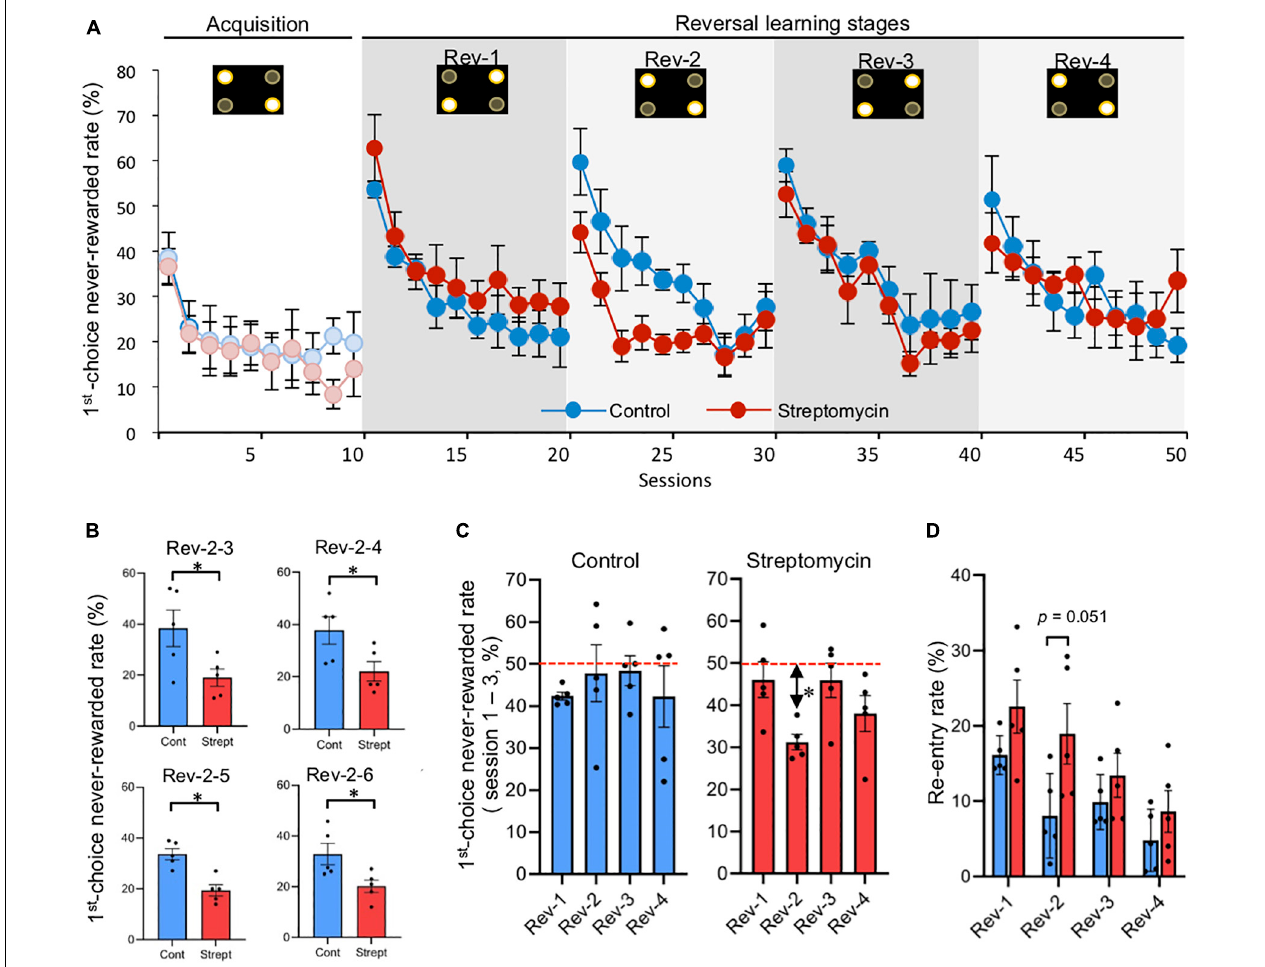
FIGURE 3 | Differences of first-choice never-rewarded rate between control mice and streptomycin-treated mice during serial reversal learning stage (sessions 11–50). (A) Change of first-choice never-rewarded rate (described in Figure 1E ) of both control mice and streptomycin-treated mice are shown ( n = 5/group). Error bars represent SEM. Active and inactive spots (described in Figure 1C ) are shown in the upper part of graph in each stage. (B) The difference between groups of the first choice never-rewarded rates in each session in the reversal stage. Only four sessions (Rev-2-3, 4, 5, and 6) showed significant differences. ∗ p < 0.05 by two-way repeated measures ANOVA with Bonferroni correction. (C) Comparison of first-choice never-rewarded rate in first three sessions of each reversal stage (data of Rev-1, Rev-2, Rev-3, and Rev-4 are the averages of Rev-1-1 to 3, Rev-2-1 to 3, Rev-3-1 to 3, and Rev-4-1 to 3, respectively, in each group). ∗ p < 0.05, significant difference from chance level (50%) using Student’s one-sample t -test. Error bars represent SEM. Horizon dotted lines represent 50% chance level. (D) Re-entry rate (described in Figure 1G ) in first three sessions of each reversal stage (data of Rev-1, Rev-2, Rev-3, and Rev-4 are the averages of Rev-1-1 to 3, Rev-2-1 to 3, Rev-3-1 to 3, and Rev-4-1 to 3, respectively, in each group). P value between-group comparison was obtained by two-way repeated measures ANOVA with Bonferroni